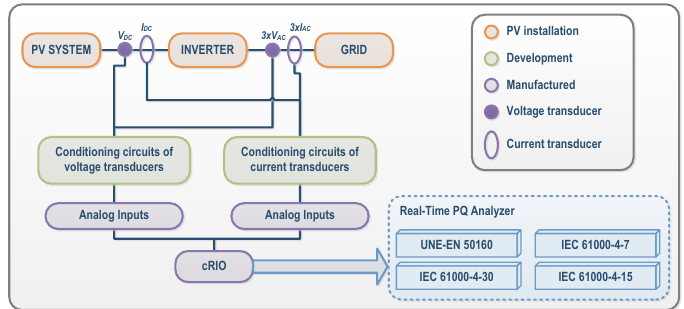
Figure 3. General structure for electrical measurements in inverters. cRIO: CompactRIO programmable controller; PQ: Power Quality.